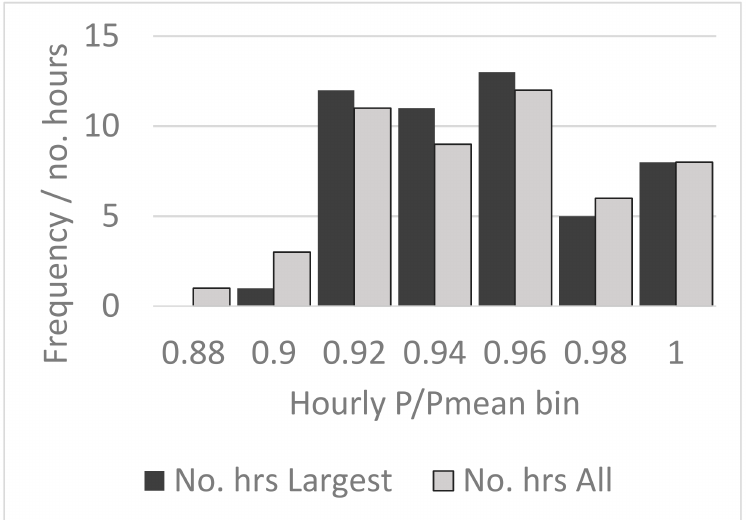
Figure 11. Frequency of 2014 power output normalized by average annual output for 4 VW solar farms for largest site and all sites.